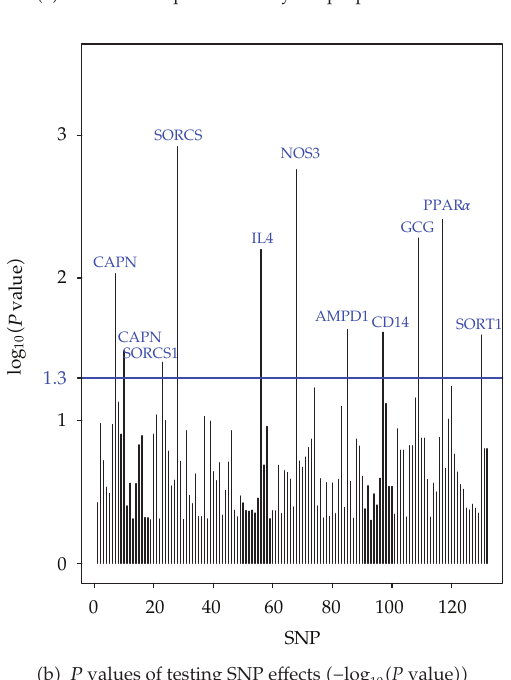
Figure 6: Analysis of genes for IGT/IFG through IFG pathway (cid:2) Data Set D2 (cid:3) with multinomial ordinal probit model with